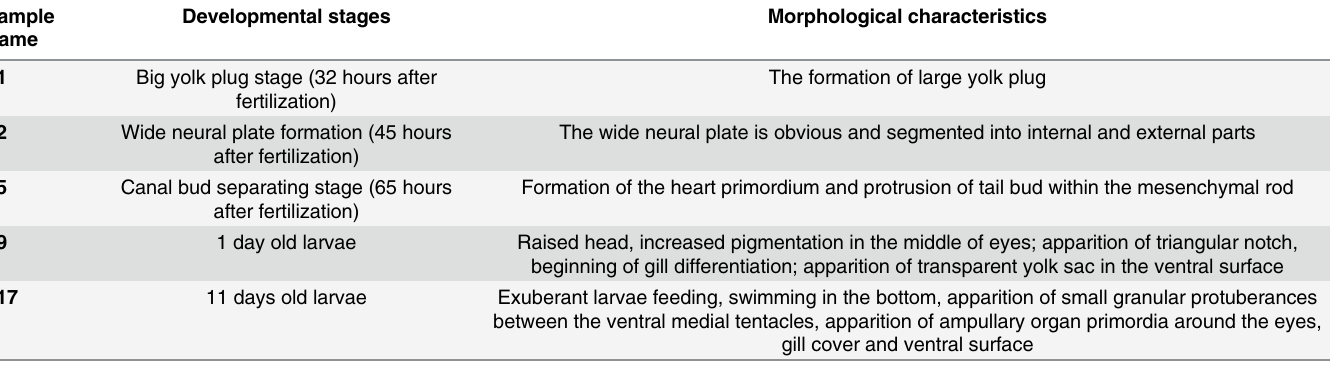
Table 1. Characteristics of fish